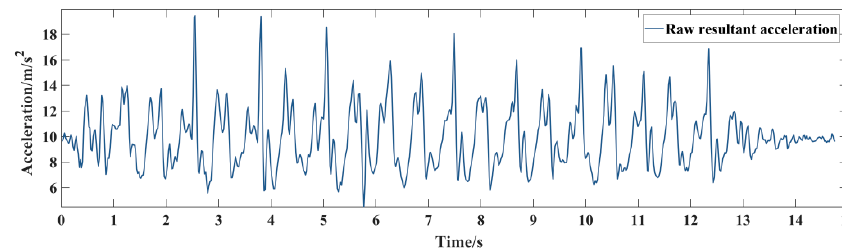
Figure 2. Raw overall acceleration signal.